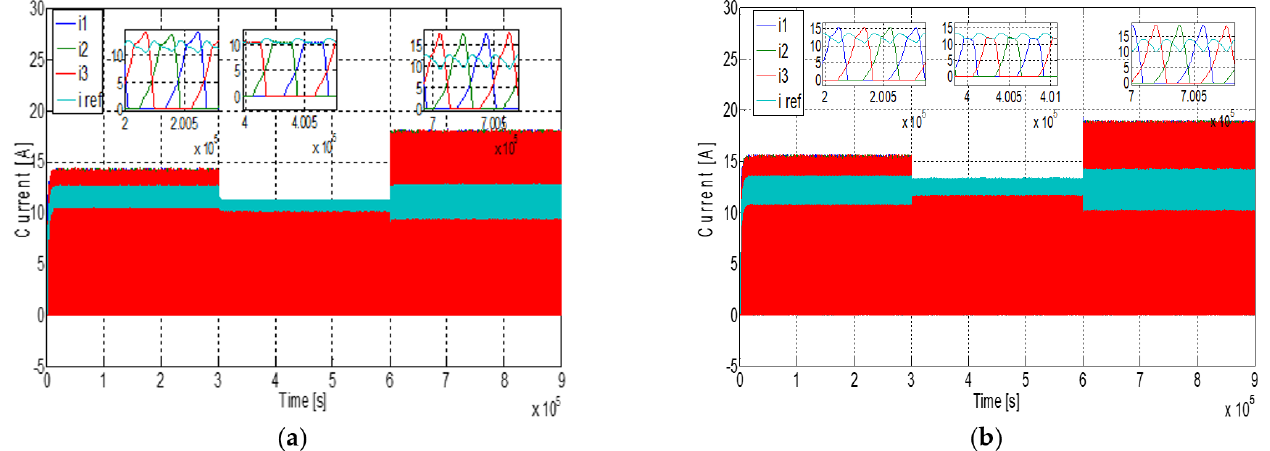
Figure 19. Current controlled by the hysteresis comparator for the three phases of the 12/8 SRG: ( a ) For: θ on = 19 ◦ and θ off = 38 ◦ ; ( b ) For: θ on = 22 ◦ and θ off = 35 ◦ .